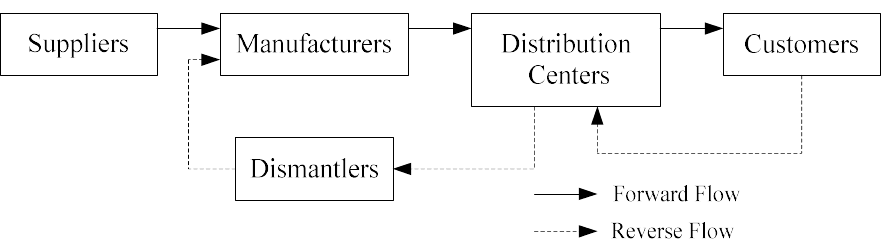
Figure 1. Concept model of the closed-loop supply chain (CLSC).